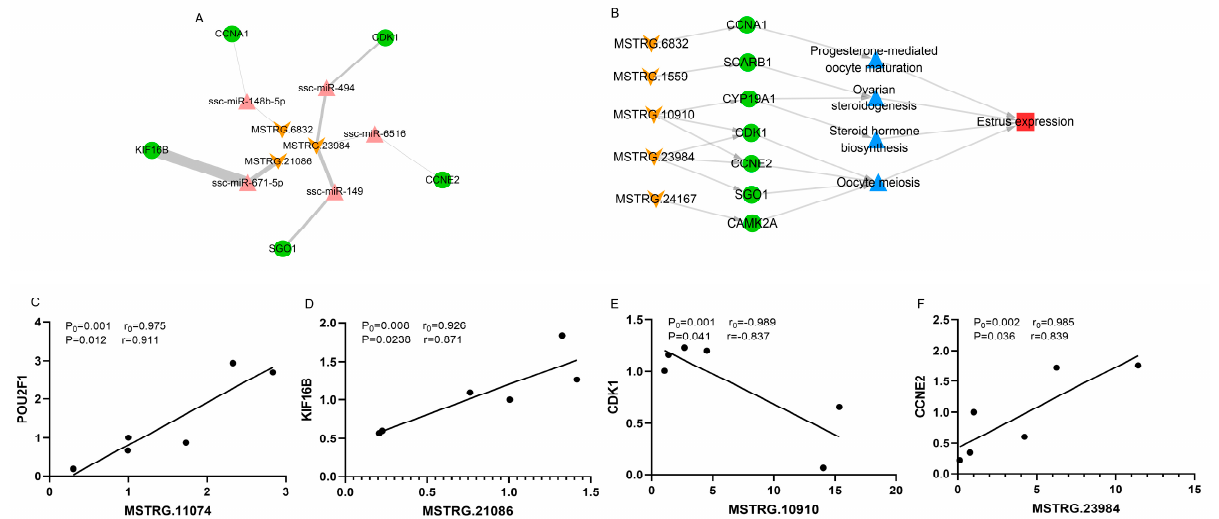
Figure 6. ceRNA network and the mechanism of DELs regulating estrus expression. ( A ) ceRNA network of DELs and DEGs. The yellow quadrilateral represents DELs, the red triangle represents miRNA, the blue circle represents DEGs, and the thickness of the edge represents energies. ( B ) The mechanism of DELs regulating estrus expression. The yellow quadrilateral represents DELs, the blue circle represents DEGs, and the blue triangle represents pathways. ( C ) Linear regression of MSTRG.11074 and POU2F1 in six samples. ( D ) Linear regression of MSTRG.21086 and KIF16B in six samples. ( E ) Linear regression of MSTRG.10910 and CDK1 in six samples. ( F ) Linear regression of MSTRG.23984 and CCNE2 in six samples. r 0 and P 0 represent the Pearson correlation coefficient and p -value by RNA-seq, and r and P represent verification by RT-qPCR.